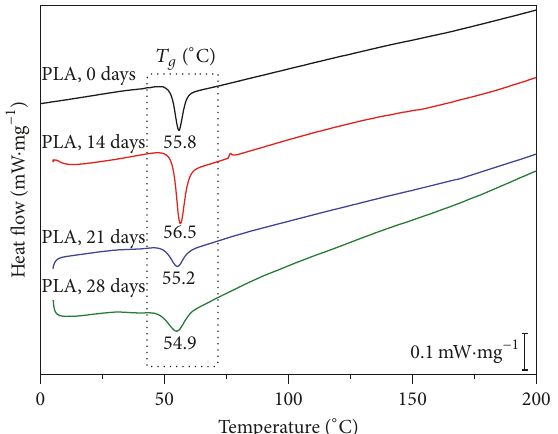
Figure 4: DSC thermograms of the PLA samples with different in vivo exposure times.